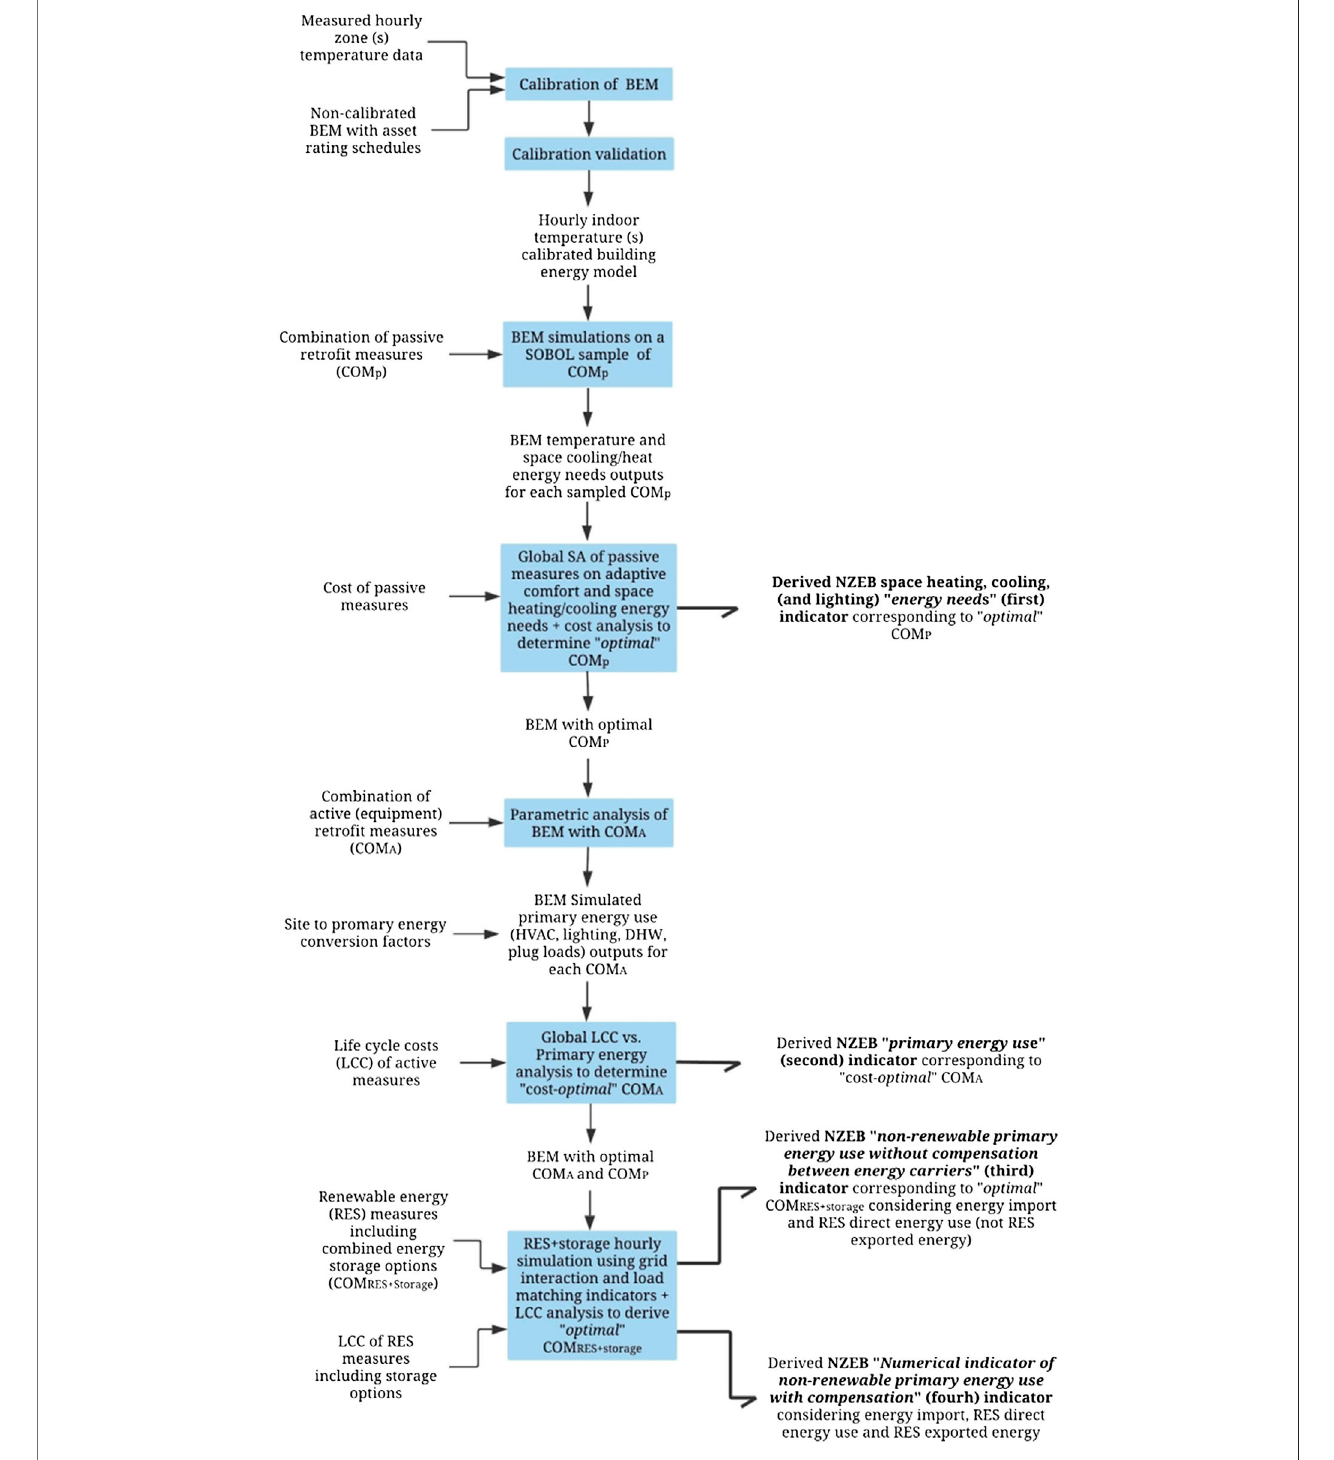
FIGURE 1 | Proposed multi-benchmark methodology approach to nearly zero energy buildings.